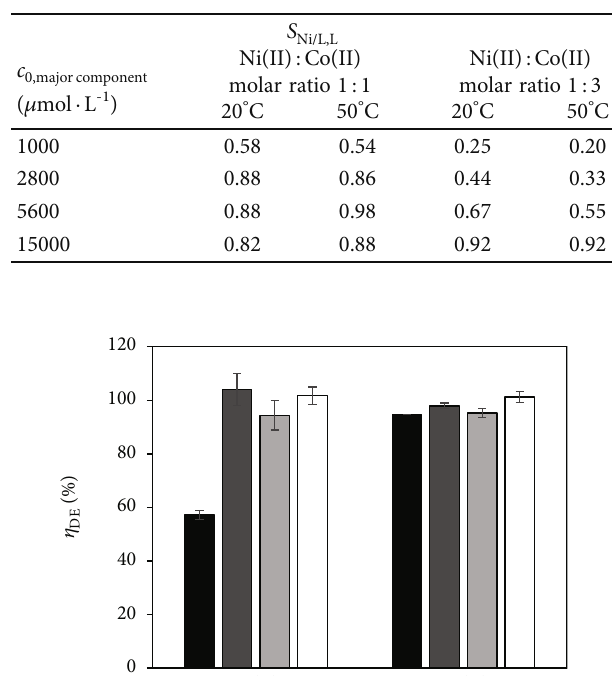
) for the Ni(II) Ni/L,L